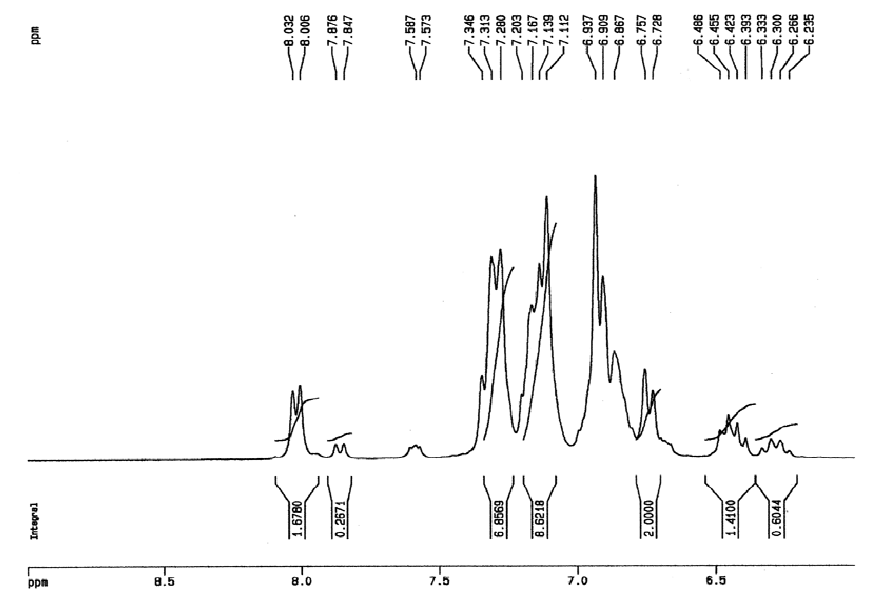
Figure 2 . 1 H NMR spectra of compound